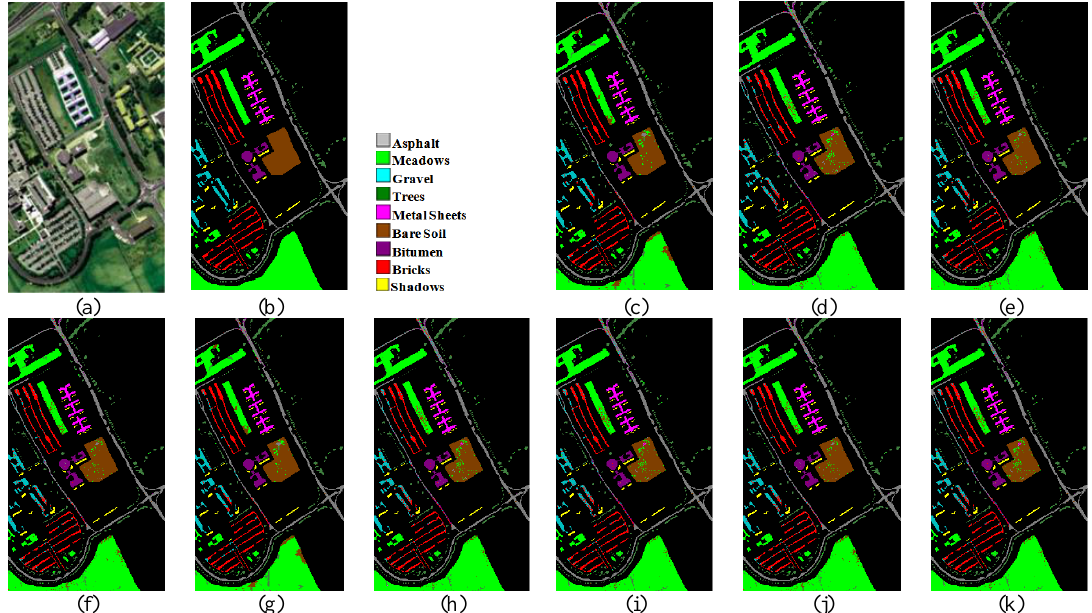
Figure 3. (a) Colour composite image, (b) Reference map, (c) Original-MMSF classification map, (d) Enhanced-MMSF classification